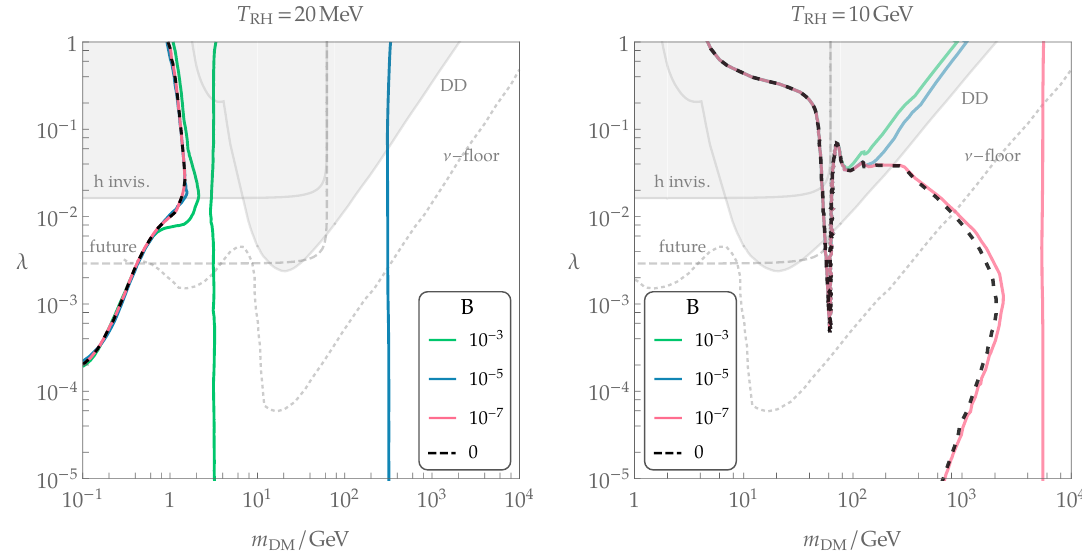
Figure 3 . Left: the parameter space for Higgs portal DM in models with a period of late time matter domination and a reheating temperature of 20 MeV. The contours show the values of the DM mass and portal coupling (cid:21) that lead to the full measured DM relic abundance, for di(cid:11)erent values of the modulus branching fraction to DM B . For small DM masses production is dominantly from the visible sector thermal bath, and chemical equilibrium is reached if (cid:21) & 10 (cid:0) 2 . At larger masses, DM is mainly produced directly from modulus decays. The current constraints from LHC searches for invisible Higgs decays (h invis.) and direct detection bounds (DD) are shown shaded gray. The future reach of searches for invisible Higgs decays at the high luminosity LHC or an e + e (cid:0) collider, sensitive to an invisible branching fraction of 1%, (future) is shown dashed gray, and the neutrino (cid:13)oor ( (cid:23) (cid:0) (cid:13)oor) is plotted with a dotted gray line. Right: the same parameter space for a model with a reheating temperature of 10 GeV. In this case production from the thermal bath can lead to viable models with relatively heavy DM if the modulus branching fraction to DM is small (chemical equilibrium is reached in such models if (cid:21) & 10 (cid:0) 3 ). For even heavier DM, production directly from modulus decays can lead to the measured DM relic abundance for small values of B , while for m DM . 200 GeV the DM is in thermal equilibrium after reheating, and the required value of (cid:21) is the same as in models with a thermal cosmological